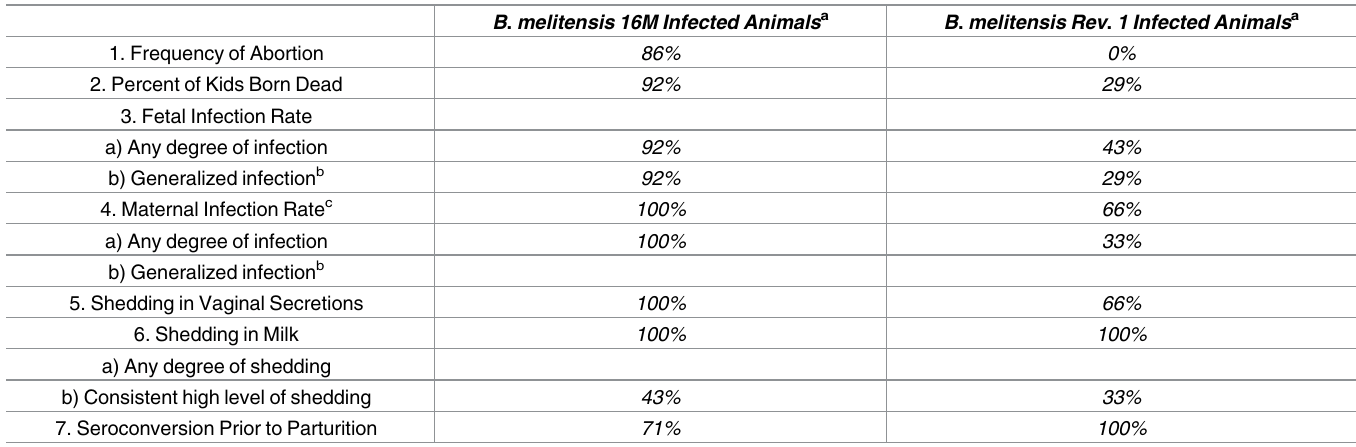
Table 5. Summaryof